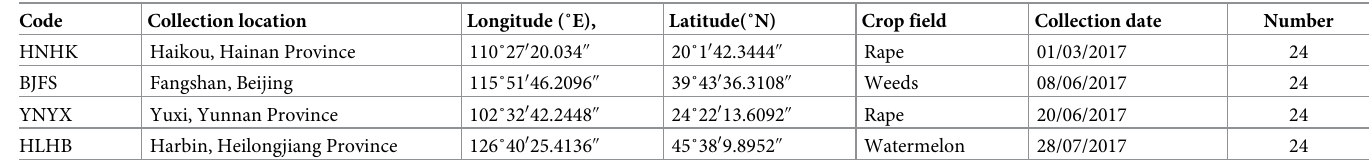
Table 1. Collection information of Eupeodes corollae for microsatellite development and population genetic structure analysis. Code